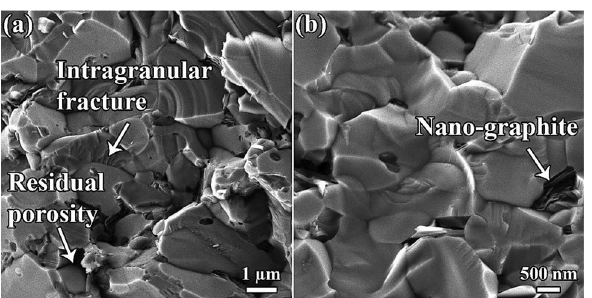
Figure 5. ( a and b ) FESEM images of C f -incorporated TiB 2 –SiC composite in different magnifications.